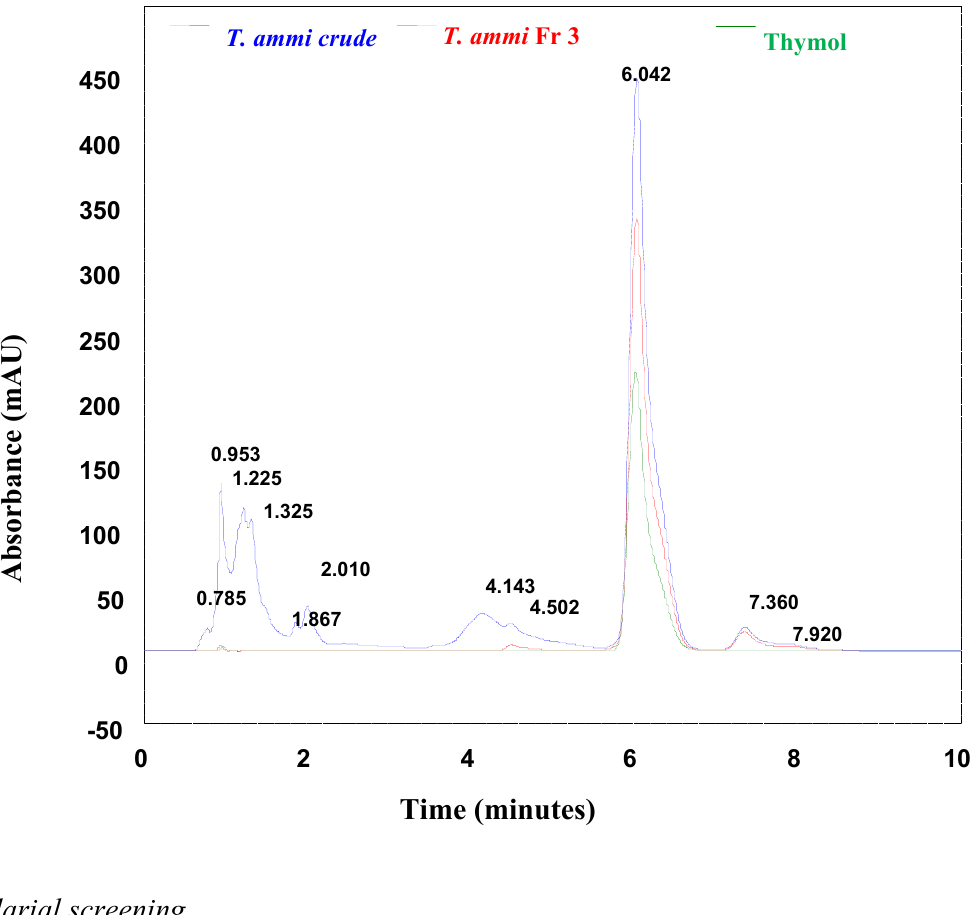
Figure 1. Overlayed HPLC analyses of T.ammi extract, active fraction and